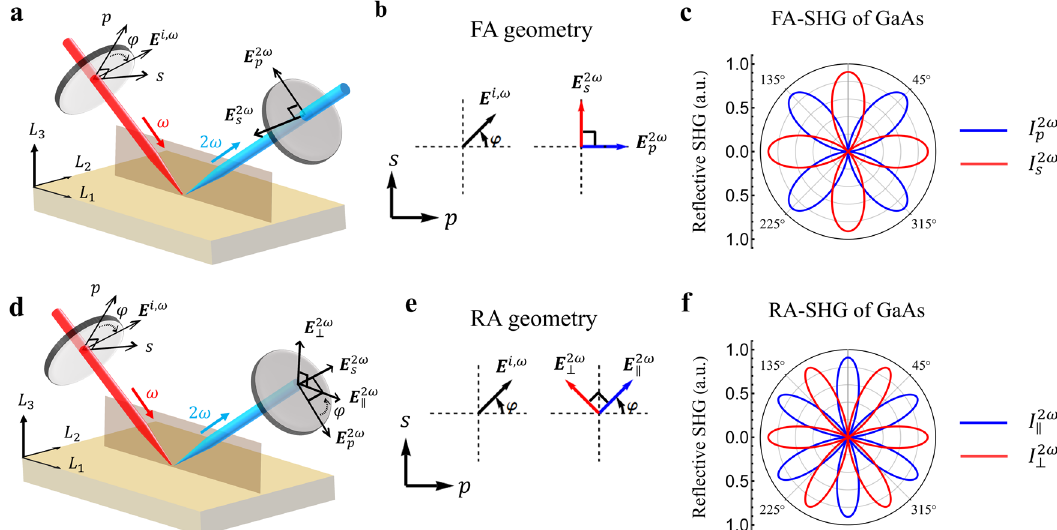
Fig. 1 Two common experimental geometries for SHG polarimetry and the resulting re fl ection SHG polarimetry for GaAs(111) surface in normal incidence. a – c Rotating polarizer fi xed analyzer (FA) geometry: SHG intensities of p - and s -polarized waves are recorded as a function of the azimuthal angle φ . d – f Rotating polarizer, rotating analyzer (RA) geometry: SHG intensities polarized parallel or perpendicular to the incident polarization are recorded as a function of the azimuthal angle φ . a , d Schematics of the experimental geometries are shown. L 1 ; L 2 ; L 3 ð Þ is the lab coordinate system. The sample surface is located in the L 1 (cid:2) L 2 plane, while the plane of incidence is parallel to the L 1 (cid:2) L 3 plane. Red and blue waves indicate a pump beam at ω and a signal beam at 2 ω frequency, respectively. b , e Schematics showing the relation between the incident polarization and SHG polarization projected in the E p (cid:2) E s plane for the two experimental geometries. c , f Polar plots of the calculated re fl ective SHG intensities for GaAs(111) surface subject to normal incidence using the two